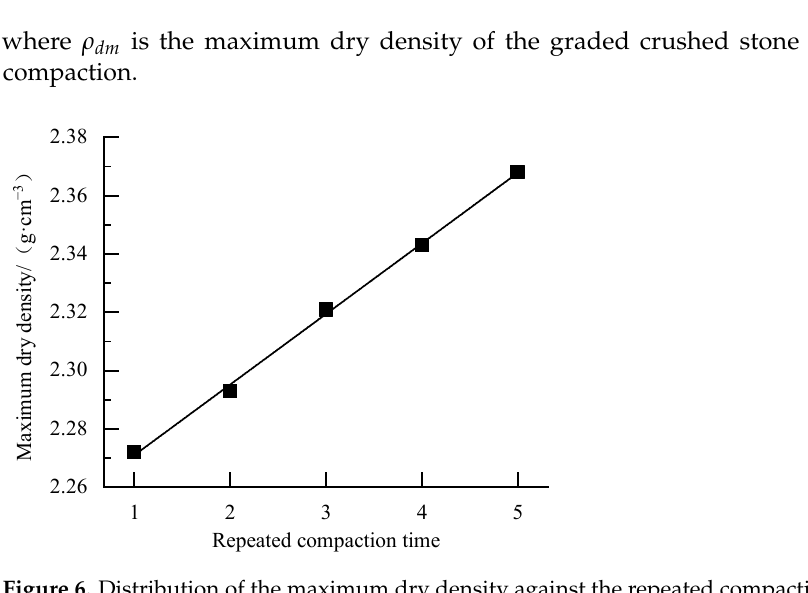
Figure 6. Distribution of the maximum dry density against the repeated compaction times.